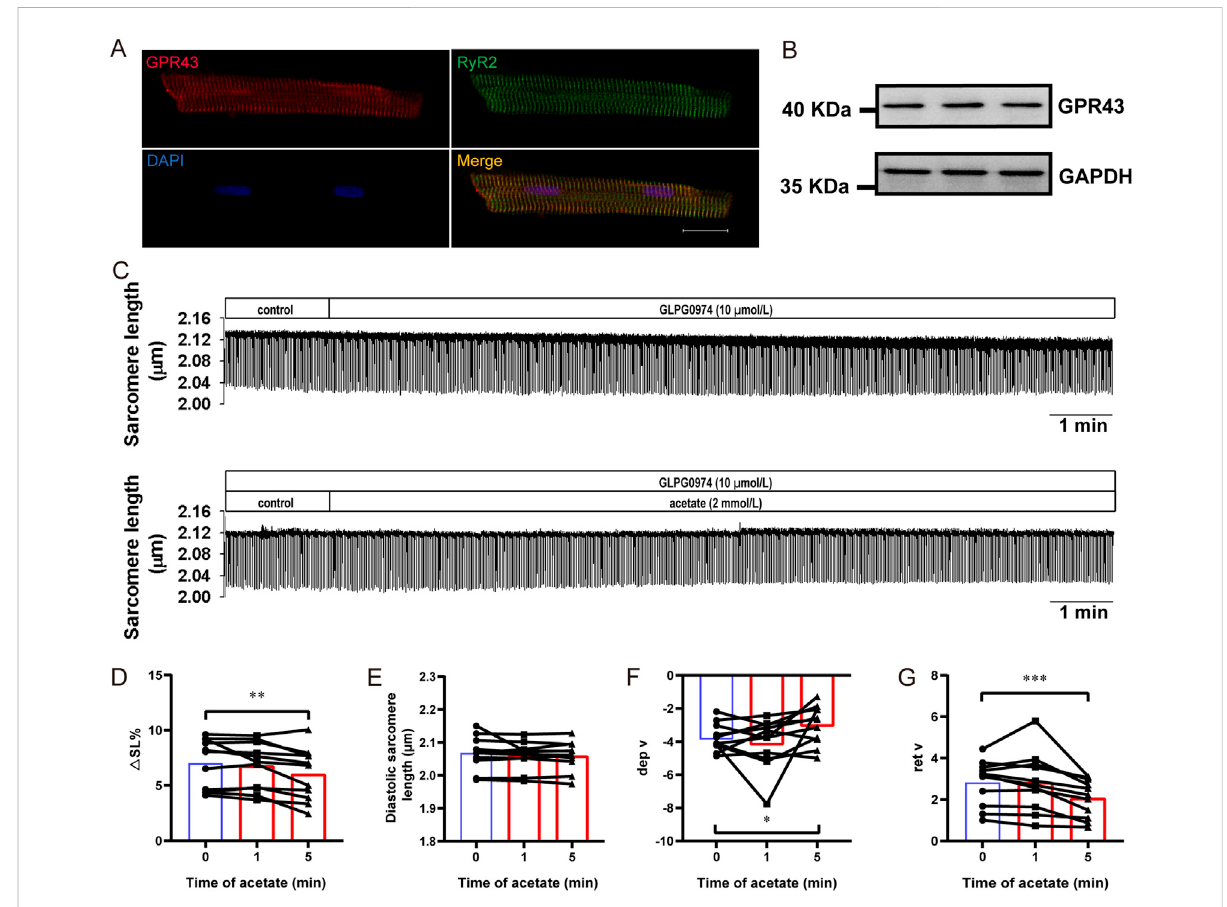
FIGURE 6 GLPG0974 prevented the acetate-induced inhibition of myocardial contraction. Photomicrographs showing GPR43 and RyR2 were co- expressedinmyocardialcell (A) ,GPR43waslabeledred,RyR2waslabeledredgreenandDAPIwaslabeledblueinthenucleus;scale bar,20 μ m.The GPR43 protein expression in myocardial cells was observed by Western blot (B) . Representative traces of myocardial contraction in isolated myocardialcells (C) .Thesarcomerecontractionamplitude (D) ,diastolicsarcomerelength (E) ,maximumcontractionvelocity (F) ,andmaximum relaxation velocity (G) in the isolated myocardial cell. N = 5, n = 11. N: the number of rats, n: the number of cells. * p < 0.05, ** p < 0.01, *** p <